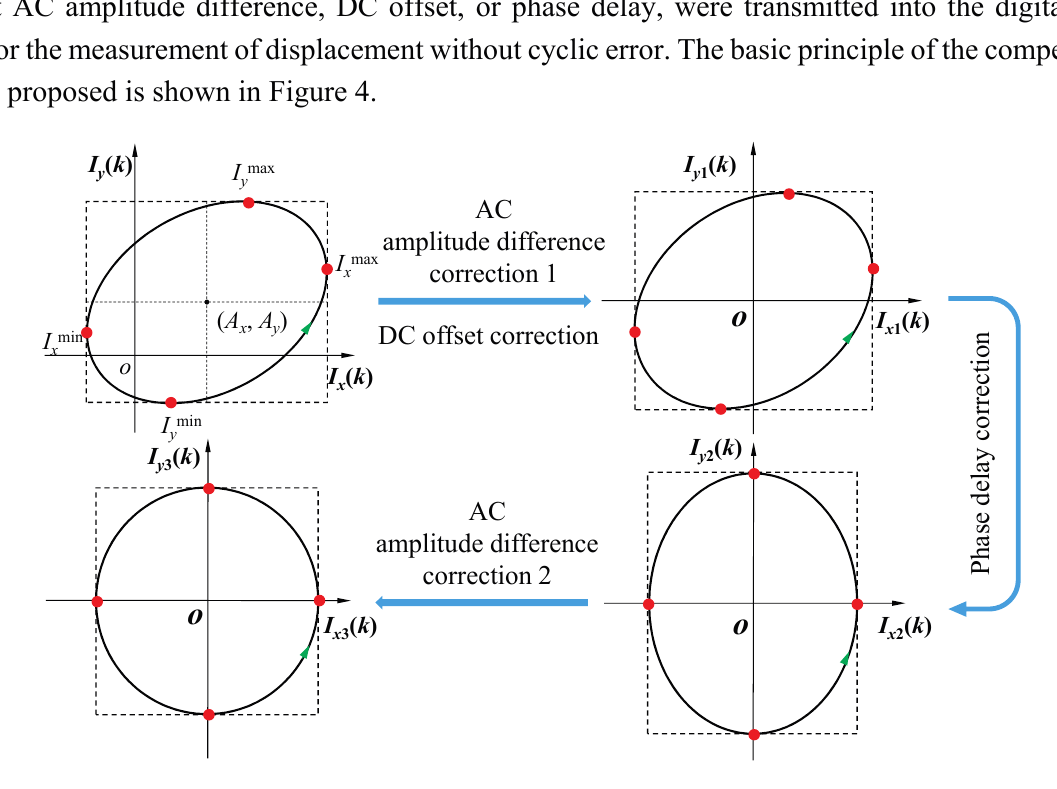
Figure 4. Schematic diagram of the compensation